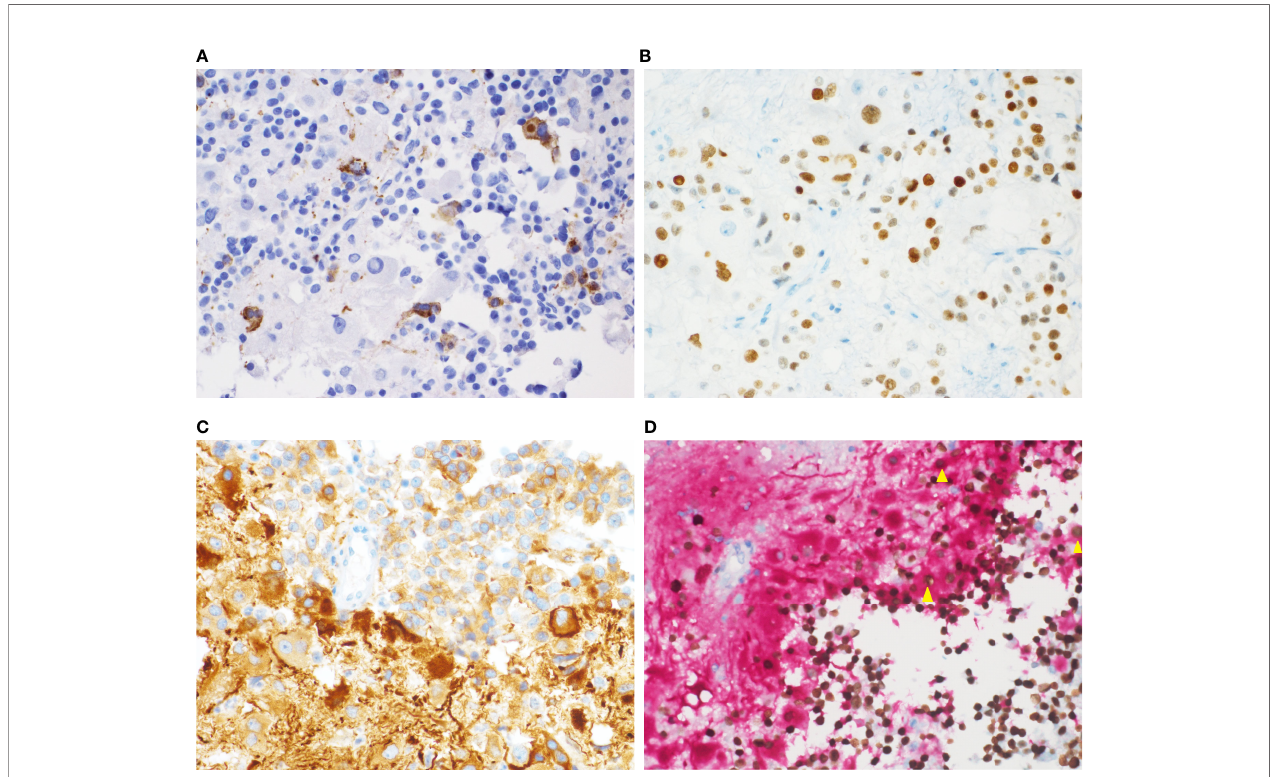
FIGURE 3 | Immunochemical staining of the mixed gangliocytoma-pituitary adenoma. (A) Some ganglion-like cells express PRL in the cytoplasm. (B) Nuclear PIT1 immunoreactivity is observed in both adenomatous cells and ganglionic cells. (C) Fibrillar matrix and large ganglion cells with prominent nucleoli show strong cytoplasmic reactivity for MAP2. (D) Double-IHC staining for PIT1 (nuclear; brown) and MAP2 (cytoplasmic; red) shows the coexpression of PIT1 (nuclear) and MAP2 (cytoplasmic) in individual cells (yellow triangle). [ (A – D) , magni fi